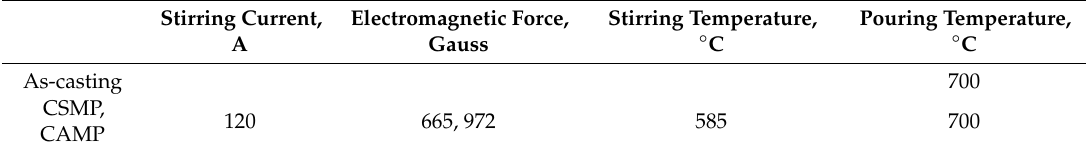
Figure 5. Photographs of A356 sample and the position of the microstructure measurement point: ( a ) As-cast billet ( b ) CSMP of Table 2; ( c ) CAMP of Table 2. Table 4. Experimental conditions of electromagnetic stirring with A356 alloy.